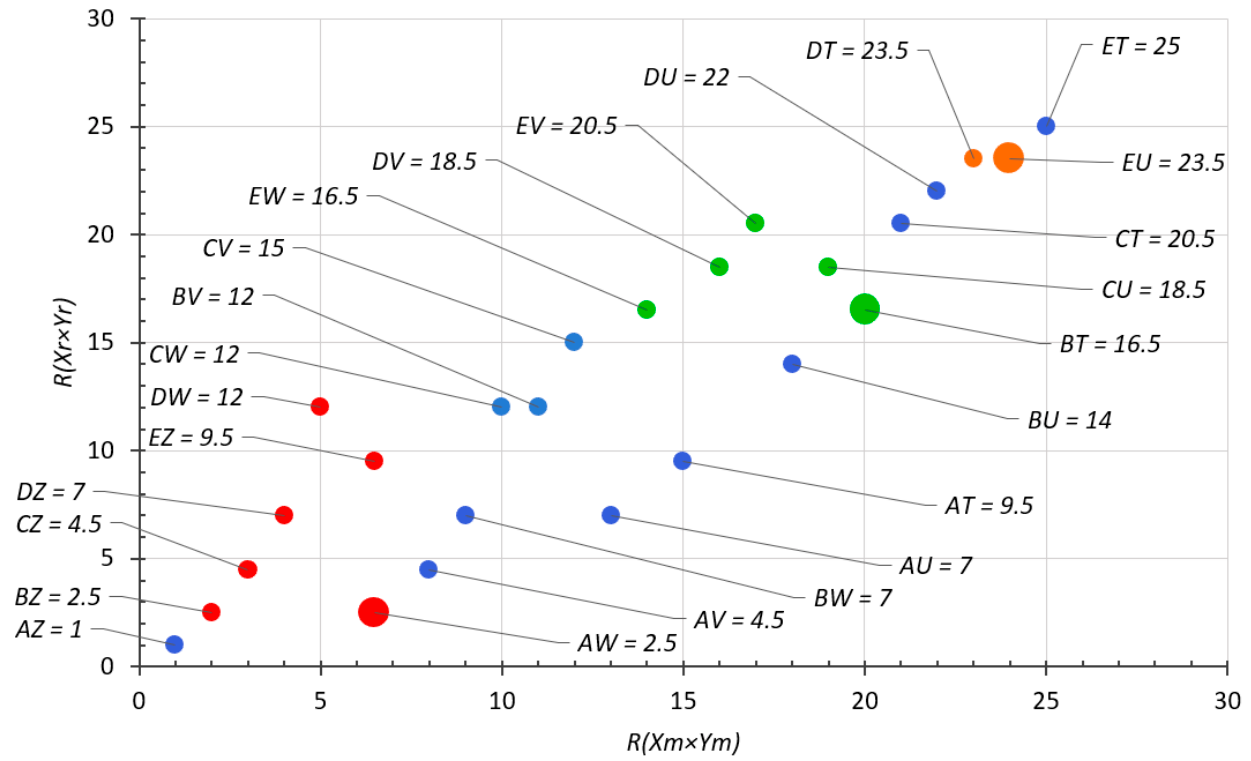
Figure 2. Comparison between the values of ranks of the products of metric values on a ratio scale R ( Xm × Ym ) and ranks of the products of ordinal values R ( Xr × Yr ) for the two sets of values of the initial data (Table 1); next to the points—their designations and values for ranks for product Xr × Yr .